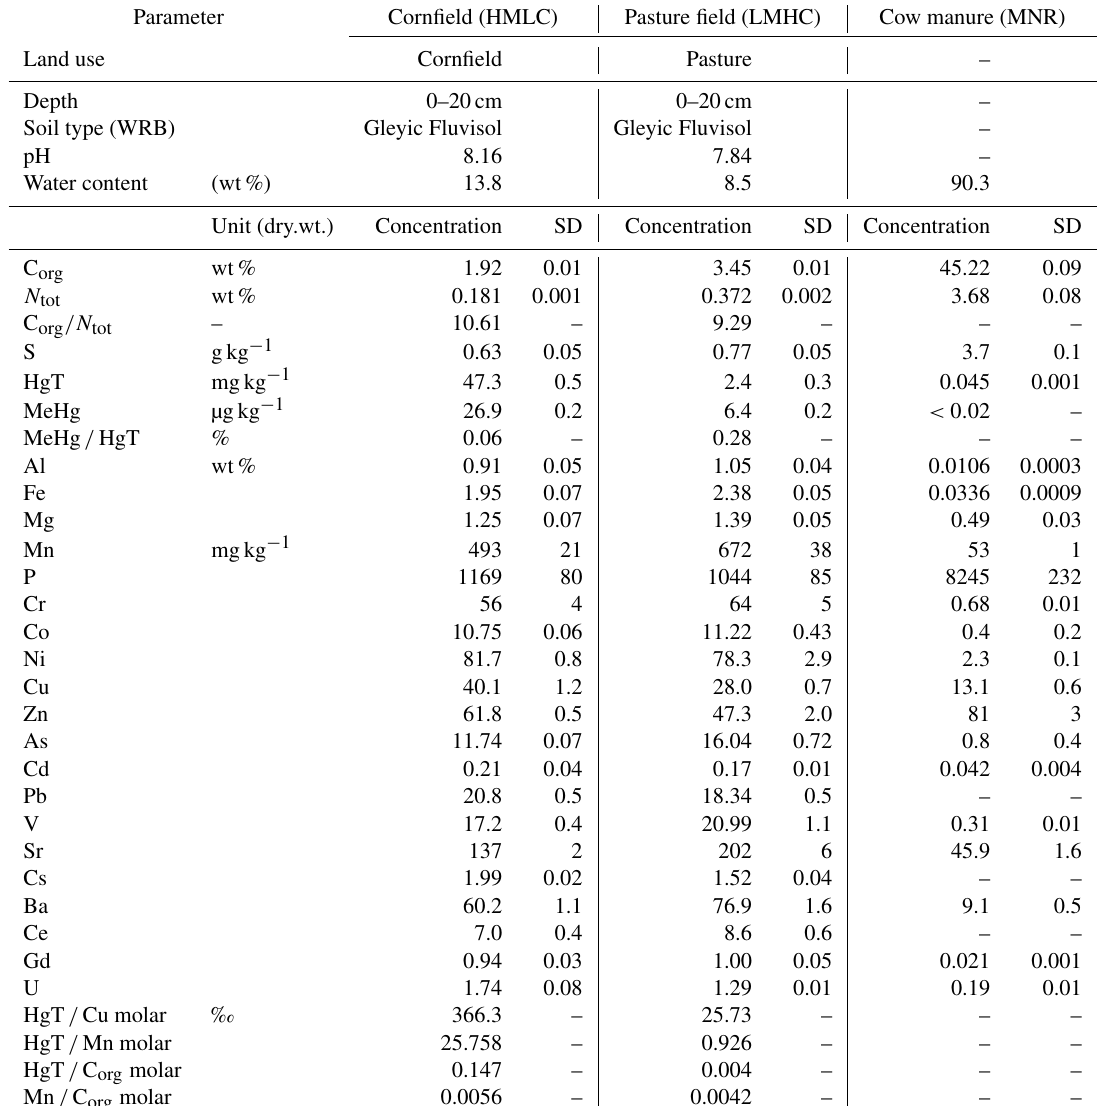
Table 1. List of soil parameters for the two incubated soils (HMLC and LMHC) and manure (MNR). Uncertainties are given as 1 σ standard deviation of triplicate experiments (method